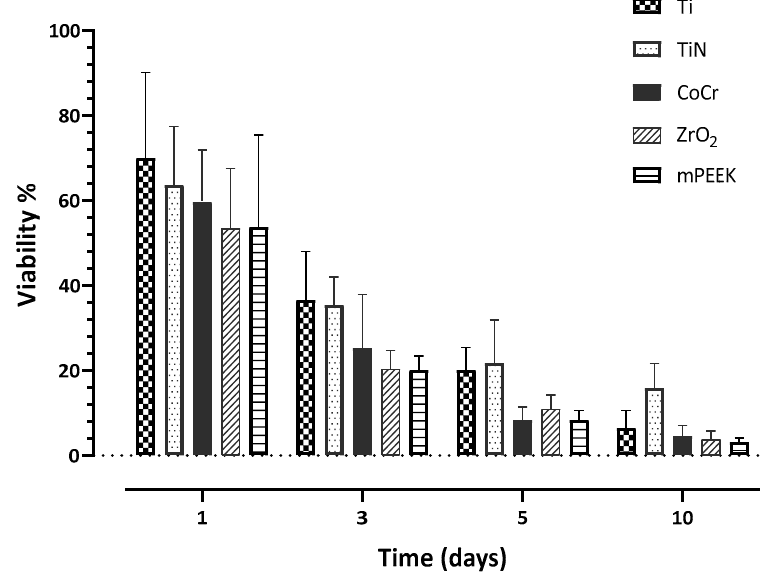
Figure 4. A bar chart illustrating the mean values of cell proliferation (viability) percentage at days 1, 3, 5, and 10 for HGKC. Error bars represent the standard deviation.